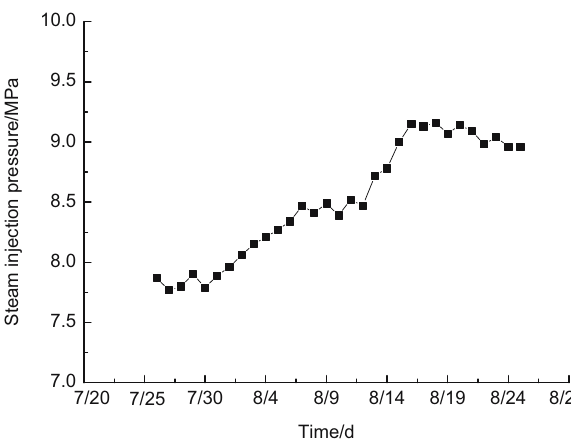
Figure 10: Steam injection pressure curve before and after pro fi le modi fi cation.